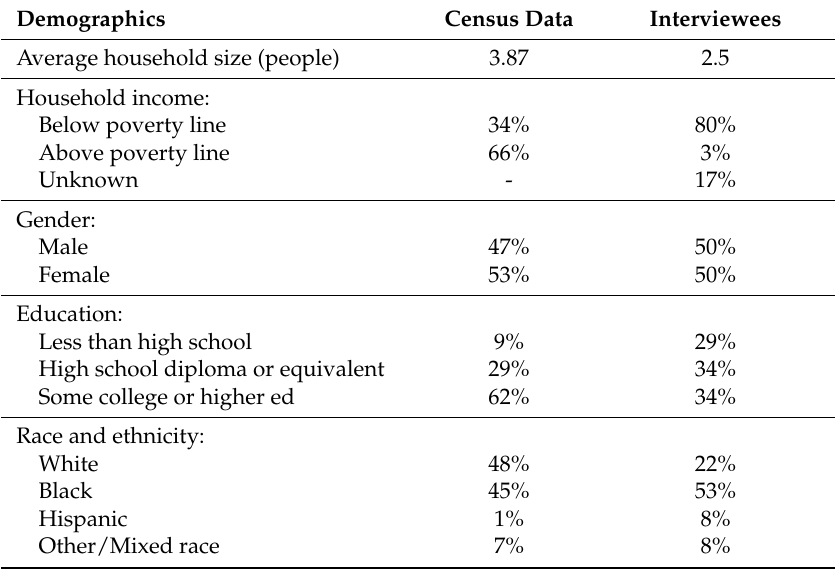
Figure 6. Images from Field Observations. Table 1. Comparison of Demographics for Census Block Group and